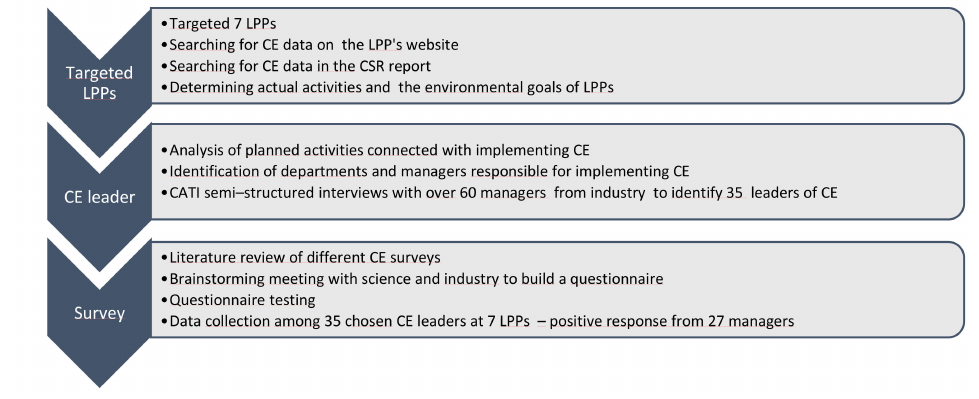
Figure 1. The circular economy (CE) implementation process.